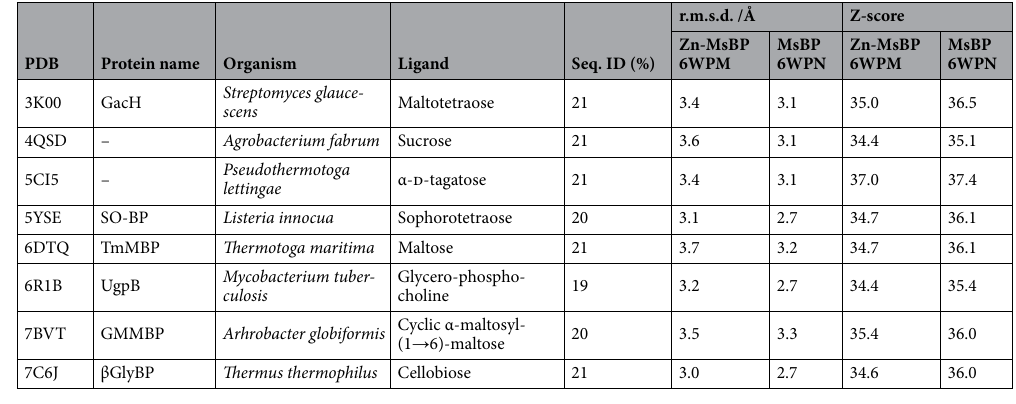
Table 1. Structural relatives of